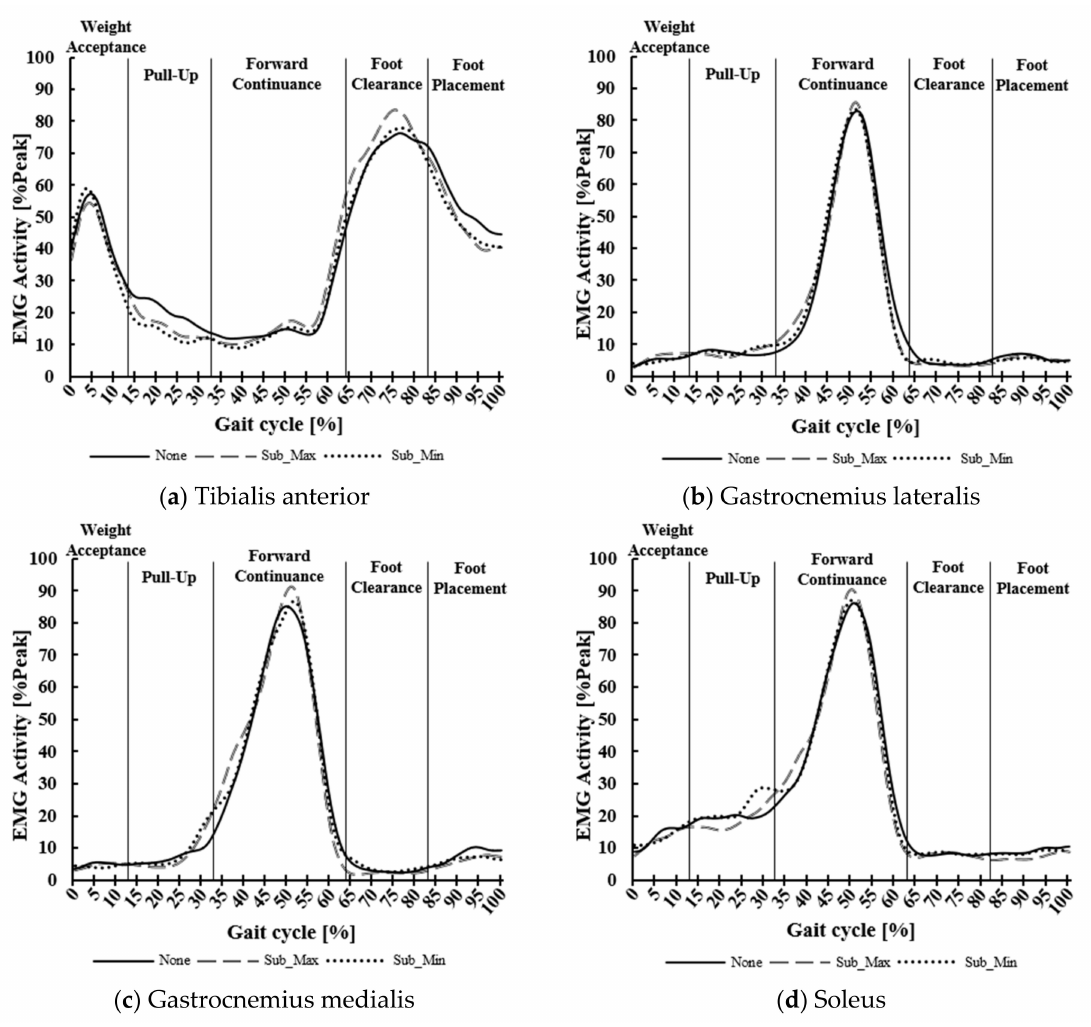
Figure 3. Mean of EMG activity of all participants in vibration stimulation conditions at sub-threshold intensity: ( a ) Tibialis anterior, ( b ) Gastrocnemius lateralis, ( c ) Gastrocnemius medialis, ( d ) Soleus. ‘Sub-Max’ means a vibration of 140 Hz was applied at sub-threshold intensity, while ‘Sub-Min’ means a vibration of 210 Hz was applied at sub-threshold intensity. The solid line indicates the gait phase (Weight Acceptance (WA, 0%~14%), Pull-Up (PU, 15%~32%), Forward Continuance (FCN, 33%~64%), Foot Clearance (FC, 65%~82%), Foot Placement (FP,